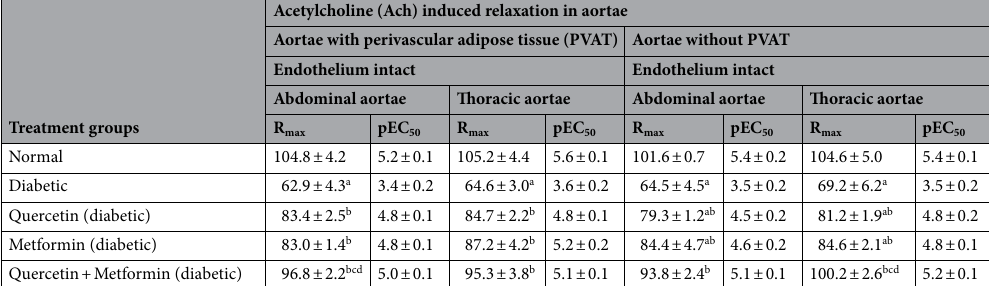
Table 2. Effect of test compounds on acetylcholine (Ach) induced relaxation in aortae. Data represent mean ± SEM. The alphabet, ‘a’ shows a significant difference in comparison with normal control ( p < 0.05). The alphabet, ‘b’ shows a significant difference in comparison to diabetic control ( p < 0.05). The alphabet, ‘c’ shows a significant difference in comparison with a quercetin treatment group ( p < 0.05). The alphabet, ‘d’ shows a significant difference in comparison with the metformin treatment group ( p < 0.05).